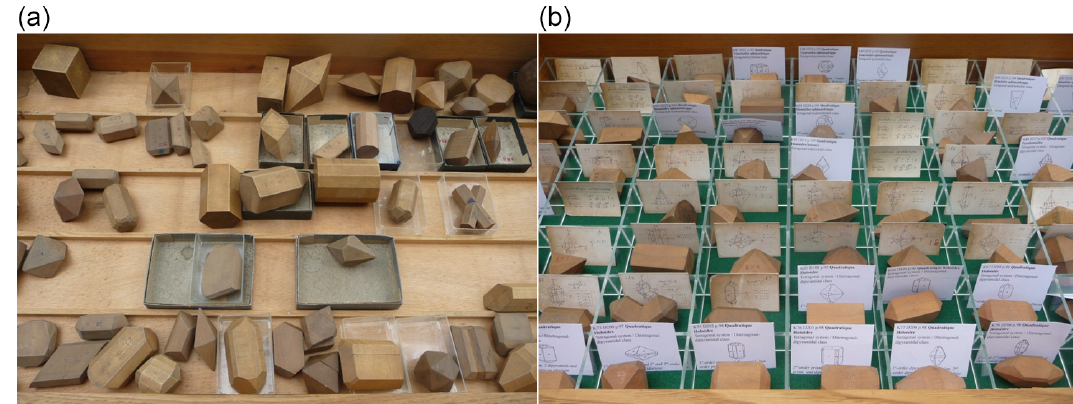
Figure 1. Some crystallographic wooden models before (a) and after (b) restoration. Dimensions of models max 70mm.